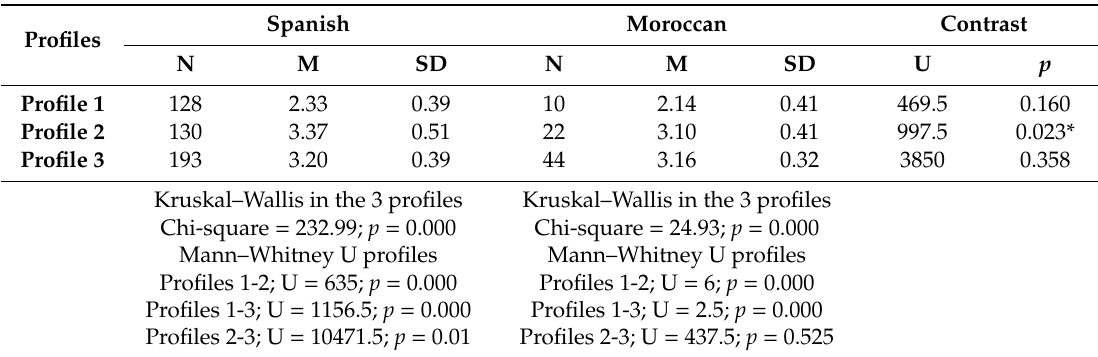
Table 3. Means, standard deviation, and contrasts using the Kruskal–Wallis and the Mann–Whitney U tests between Spanish and Moroccan